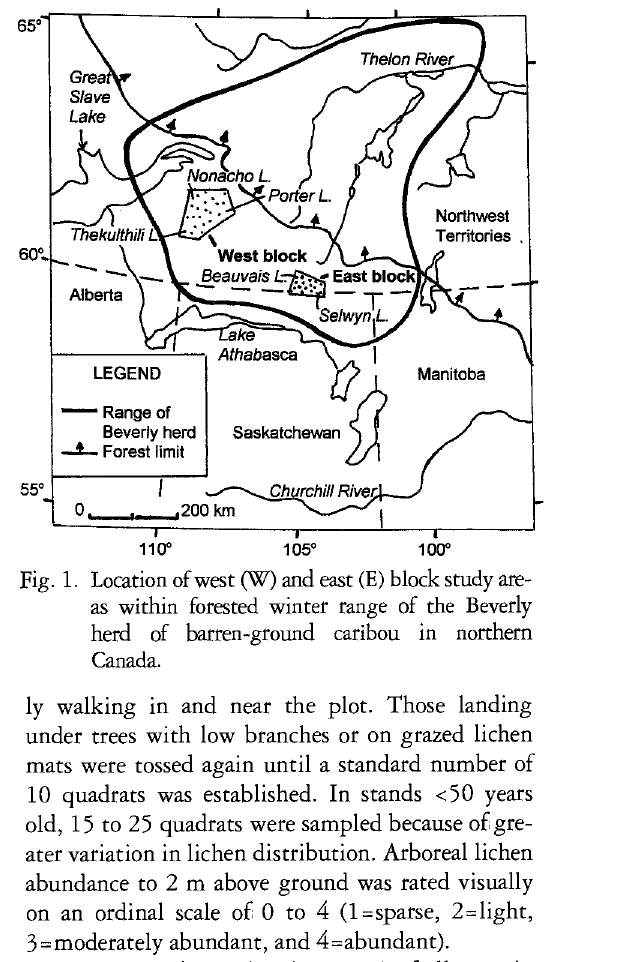
Fig. 1. Location of west (W) and east (E) block study are as within forested winter range of the Beverly herd of barren-ground caribou in northern